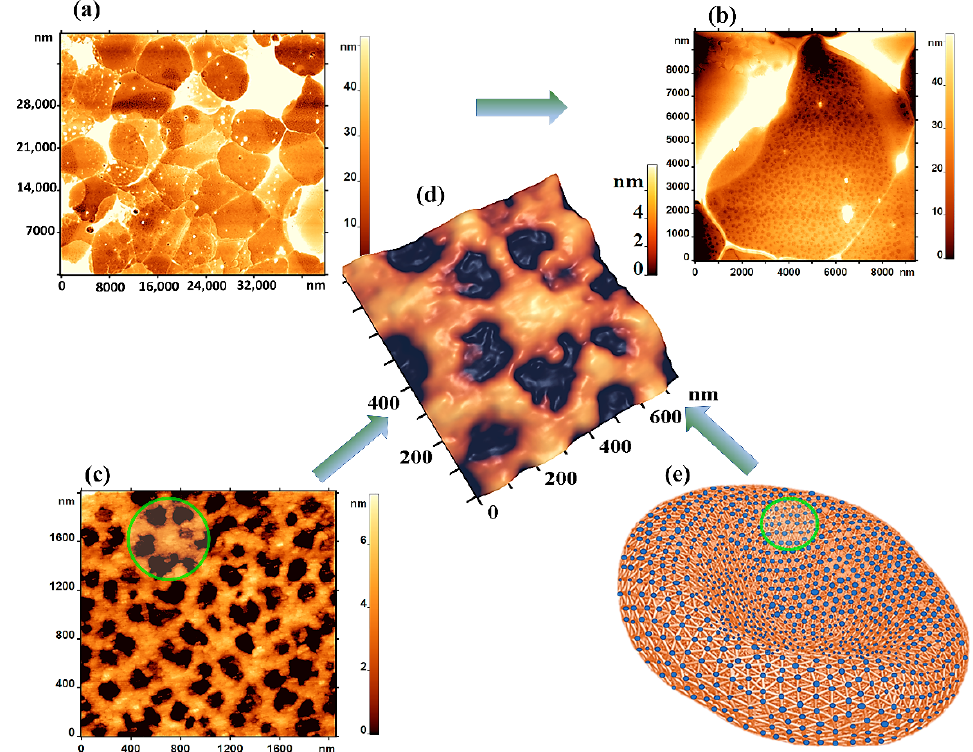
Figure 3. AFM images of the cytoskeleton: ( a ) Monolayer of ghost control cells (35 × 35 µm 2 ); ( b ) Single RBC ghost (10 × 10 µm 2 ); ( c ) Cytoskeleton section (1.8 × 1.6 µm 2 ); ( d ) 3D AFM image of a section of the RBC cytoskeleton (0.8 × 0.7 µm 2 ); ( e ) Model of the RBC cytoskeleton.